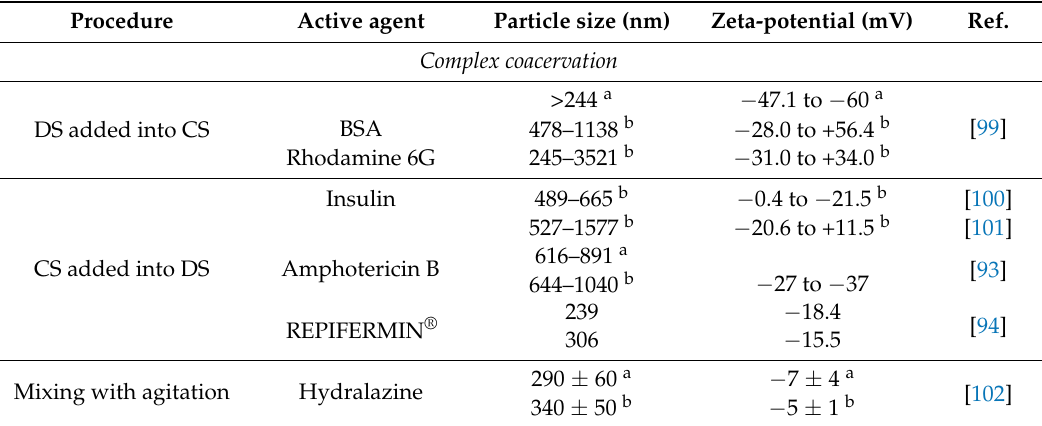
Table 3. Chitosan-Dextran sulfate PEC nanoparticles. The intervals shown generally indicate extreme values obtained under different preparation